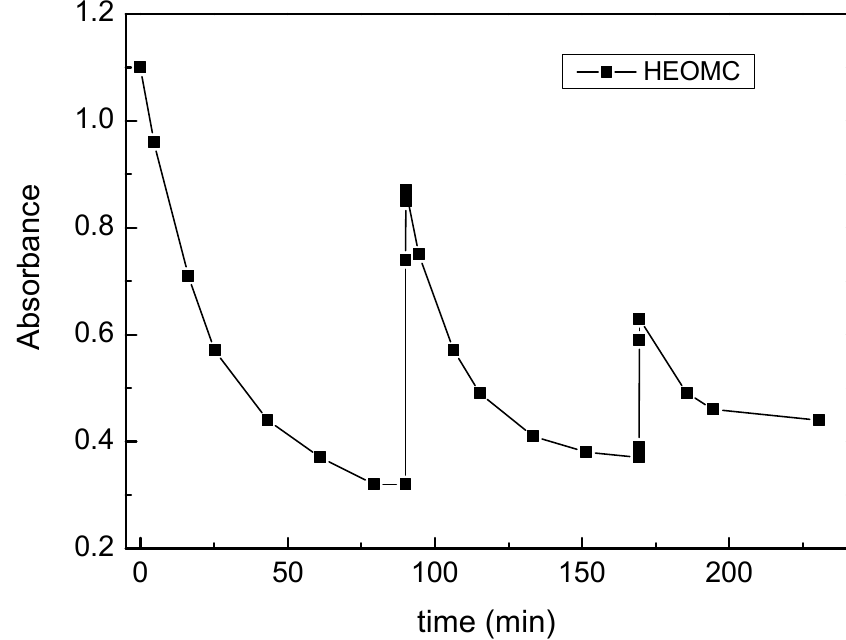
Figure 5. Photo-dimerization and photo-cleavage absorptions of HEOMC derivative cycle by cycle.